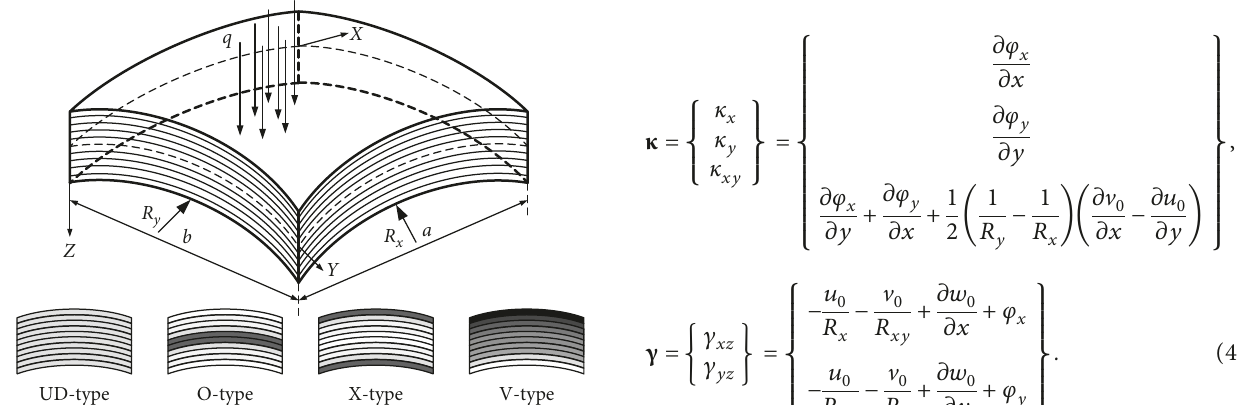
Figure 1: Composite shell with 4 graphene reinforcement